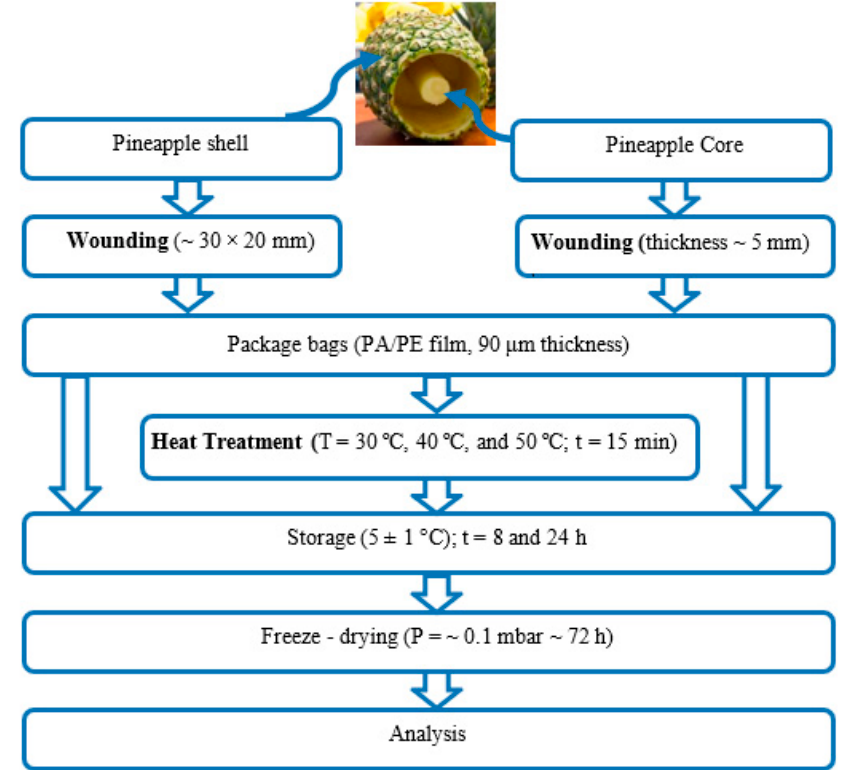
Figure 1. Schematic representation of a longitudinal section of a pineapple fruit and flow diagram of the abiotic stress treatments (wounding and thermal treatment).